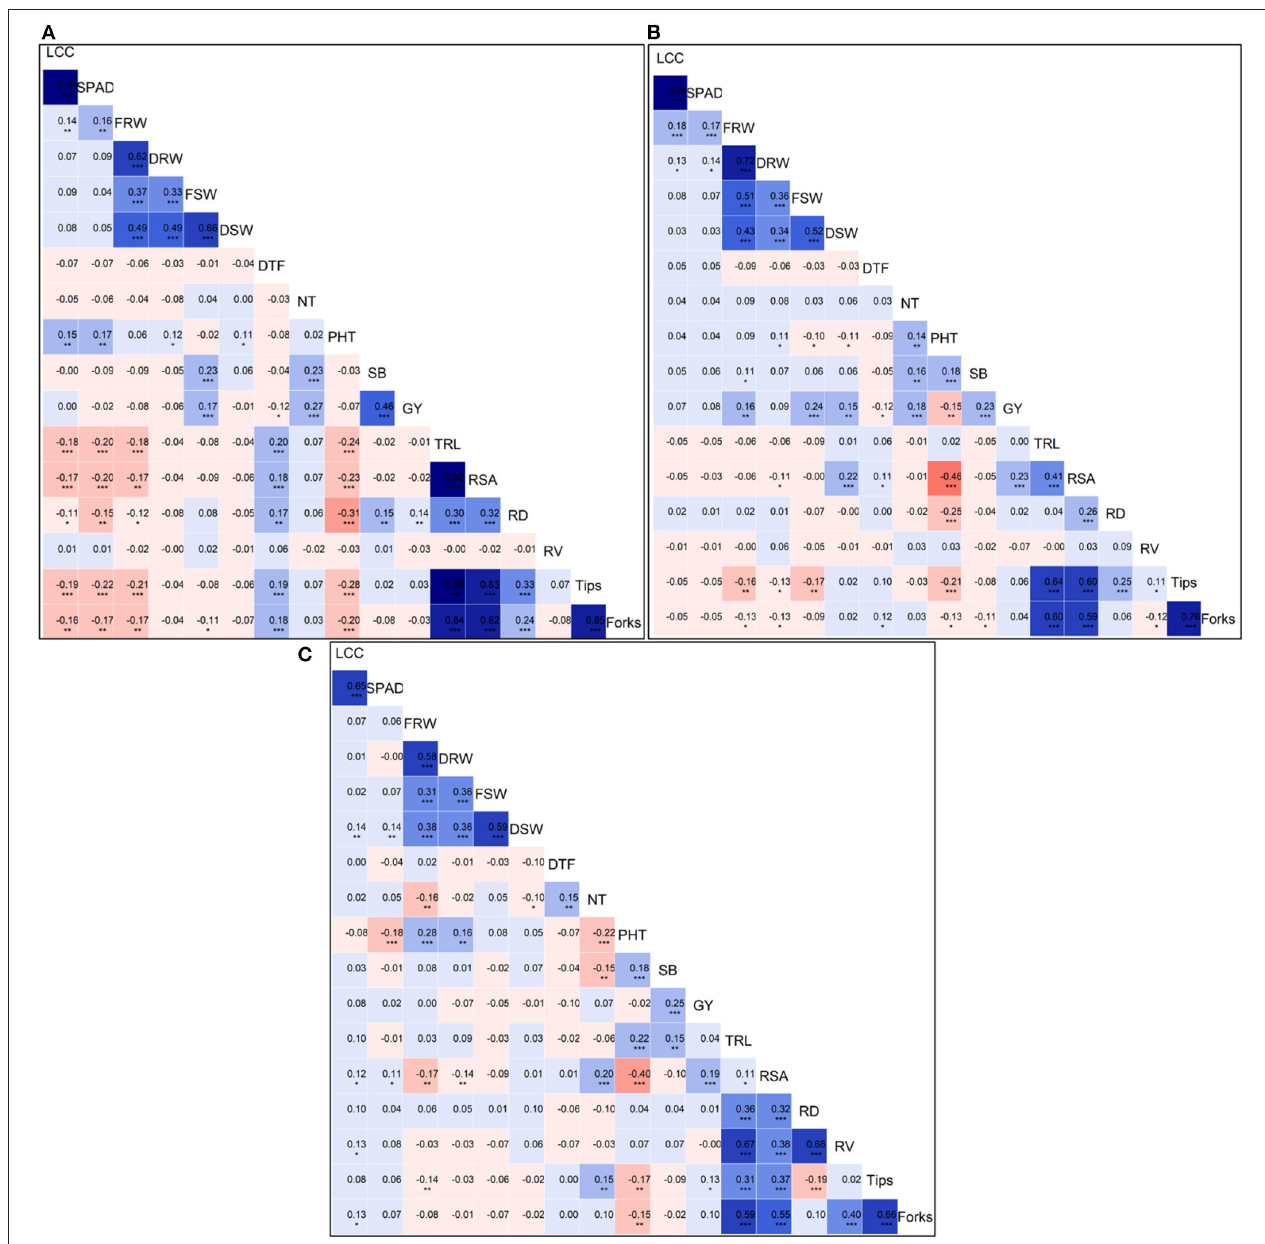
FIGURE 2 | Plots of Pearson’s r-values showing the correlation among traits measured (A) measured at N0, (B) N60, and (C) N120 levels. The blue color indicates positive correlation and red color indicates the negative correlation among different traits, the variation in color intensity represents the strength of the correlation among the traits. *Significance at < 5% level, **significance at < 1% level, ***significance at < 0.1%